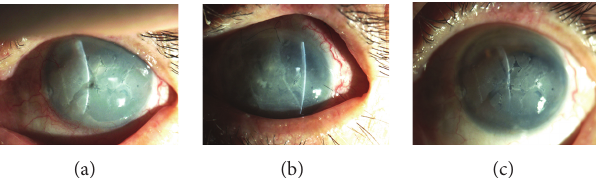
Figure 1: Healing of a central corneal perforation after performing FG-assisted AMT–plug. (a) A preoperative photograph of corneal perfo- ration due to noninfectious corneal ulcer. (b) A postoperative photograph of FG-assisted AMT-plug in the defect with amniotic membrane patch overlaid, 3 days after application. (c) A stable corneal scar with nearly normal thickness and a smooth corneal surface is seen 3 months postoperatively.